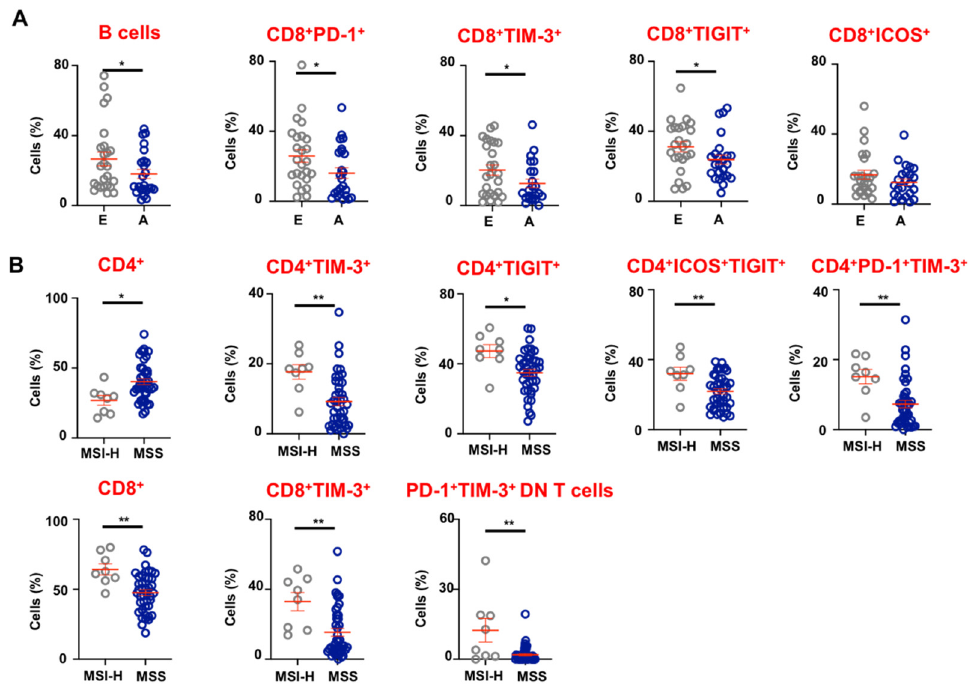
Figure 4. Levels of tumor-infiltrating lymphoid cells in CRC patients with different disease stages and microsatellite instability-high (MSI-H) versus microsatellite stable (MSS) tumors. We divided the 50 patients into two groups; early Scheme 25. and advanced stage (III and IV, n = 25, and investigated differences in levels of tumor-infiltrating lymphocytes (TILs) between the two groups. Cumulative scatter plots show differences in levels of B cells, CD8 + PD-1 + , CD8 + TIM-3 + , CD8 + TIGIT + , and CD8 + ICOS + T cells in CRC patients with advanced stage compared to early stage ( A ). We also divided patients into two groups based on expression of MMR proteins to identify patients with MSI-H (n = 8) and MSS (n = 42) tumors, and investigated differences in levels of TILs between the two groups. Cumulative scatter plots show differences in levels of CD4 + , CD4 + TIM-3 + , CD4 + TIGIT + , CD4 + ICOS + TIGIT + , and CD4 + PD-1 + TIM-3 + T cells, and CD8 + , CD8 + TIM-3 + and CD4 + , PD-1 + TIM-3 + DN T cells, in CRC patients with MSI-H compared to MSS tumors ( B ). The p values are represented as follows; * p < 0.05, ** p < 0.01.